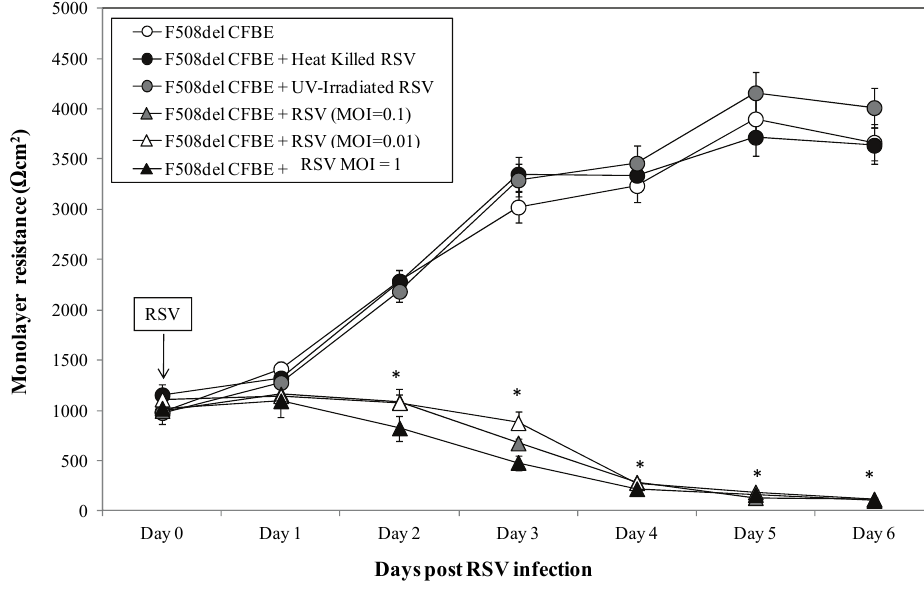
Figure 2. Resistance measurement across F508del CFTR expressing CFBE41o- cells post inoculation with live and killed RSV. Transepithelial measurements were obtained in uninfected CFBE41o- cells expressing F508del CFTR (white circles), as well as F508del CFTR cells infected with UV-irradiated RSV (grey circles), heat-killed RSV (black circles) and live RSV (MOI = 0.01 white triangles, MOI = 0.1 grey triangles and MOI = 1 black triangles). Monolayer resistance was measured daily from time of infection through Day 6